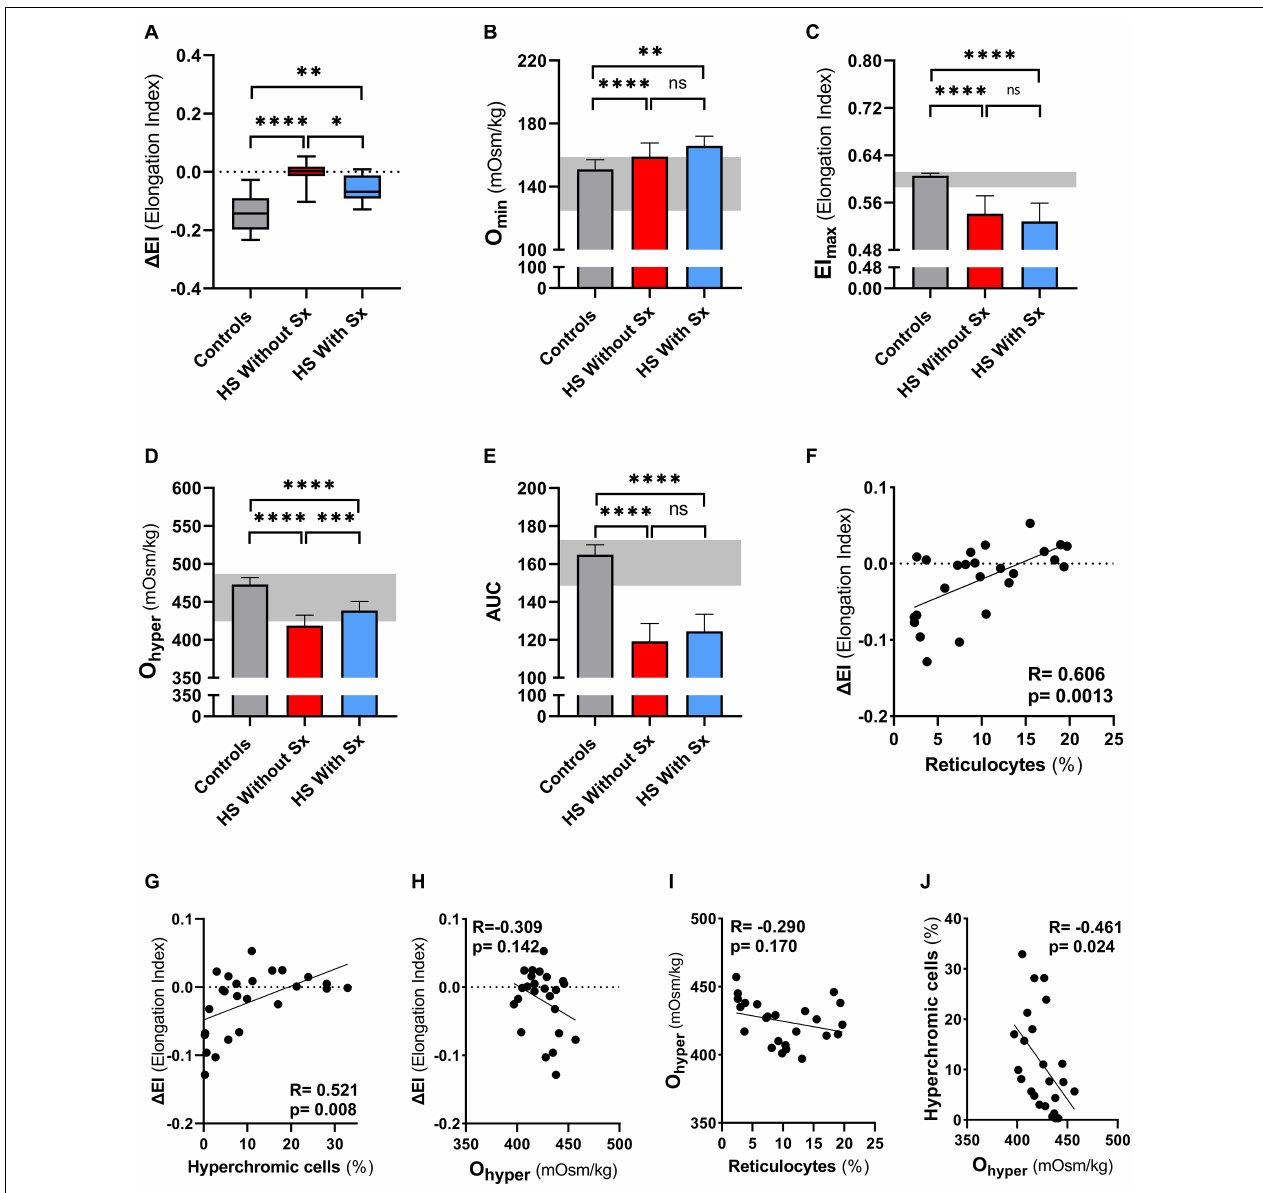
FIGURE 4 | Cell membrane stability test (CMST) and the calculated parameter ( (cid:49) EI) shows improvement in splenectomized patients with HS in a case-control study. CMST-derived parameter (cid:49) EI [panels (A,F,G,H) ], osmotic gradient ektacytometry-derived parameters [panels (B–E,H,I,J) ], reticulocytes and hyperchromic cells were assessed in 18 non-splenectomized HS patients, 8 non-splenectomized HS patients and 26 healthy controls (HC). (A) Mean (cid:49) EI of HS patients without splenectomy compared to patients with splenectomy, both groups were compared to HCs. (B) Mean values of Omin are increased in splenectomized patients compared to HCs or non-splenectomized HS. (C) Mean values of EImax are decreased in splenectomized HS patient RBCs, compared to HC and non-splenectomized HS RBCs. (D) Mean values of Ohyper are significantly different between the 3 groups mentioned above. (E) Mean values of AUC show no significant differences between non-splenectomized and splenectomized HS RBCs. (F) Linear correlation between reticulocytes (%) and (cid:49) EI of HS patients. (G) Linear correlation between hyperchromic cells (%) and (cid:49) EI of HS patients. (H) Linear correlation between Ohyper and (cid:49) EI. (I) Linear correlation between reticulocytes (%) and Ohyper. (J) Linear correlation between hyperchromic cells and Ohyper. Error bars represent standard deviation. **** p < 0.0001, *** p < 0.001, ** p < 0.01, * p ≤ 0.05; ns, non-significant. Sx, splenectomy; HS, hereditary spherocytosis; AUC, area under the